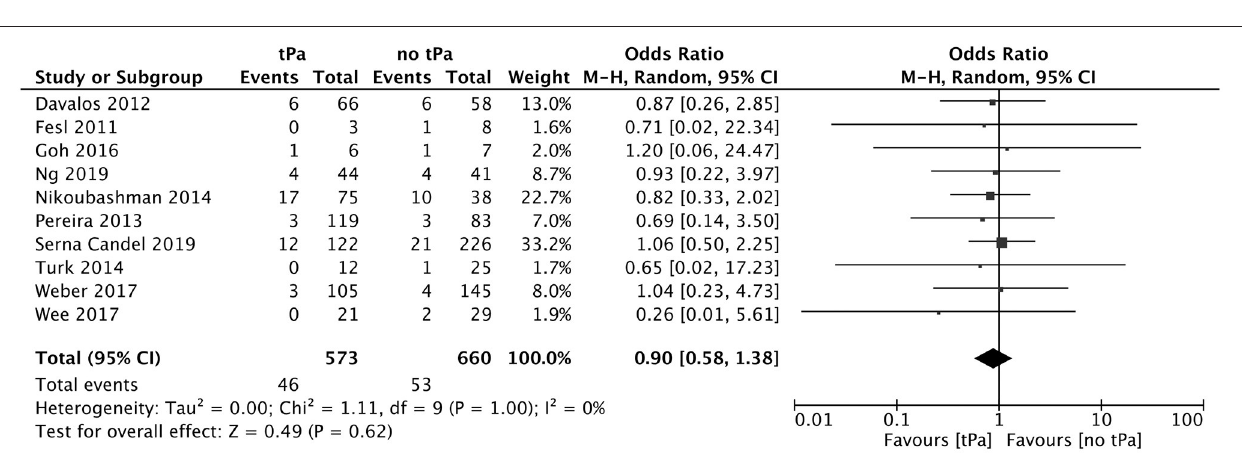
independently suggested distality to be a risk factor for SAH with more instances following thrombectomy of M2-situated clots (62.5 vs. 37.7%, p = 0.26) and when > 2 cm of the stent was deployed within a M2 branch (100 vs. 30.2% p = 0.002) (8). The M2 segment of the MCA is on average 1 mm (25%) smaller than the parent vessel at its origin (36, 37). These smaller diameter vessels that closely-match the outer diameter of the smallest stent retrievers and distal access catheters coupled